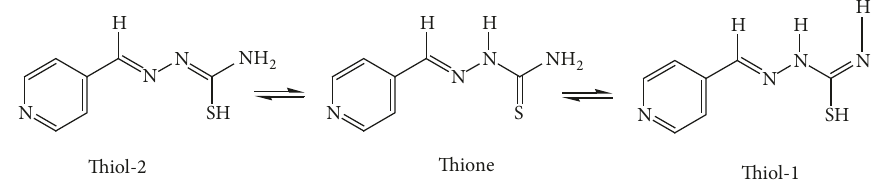
Figure 1: Thione and thiol forms of the H4FPT.